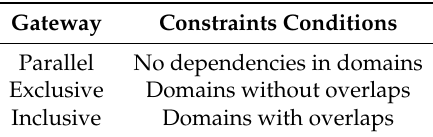
Table 2. Type of gateway decision.